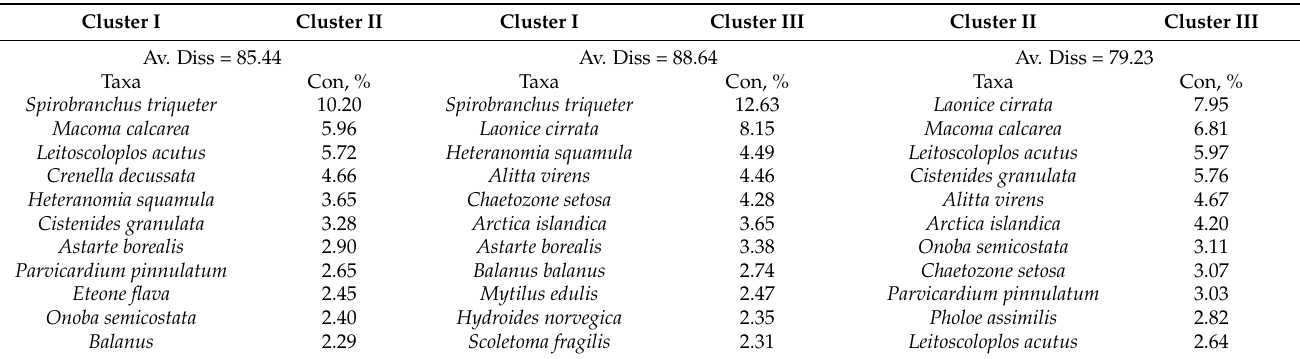
Table 3. List of taxa which contributed the most to dissimilarity within groups of benthic communities delineated with cluster analysis in Kola Bay.